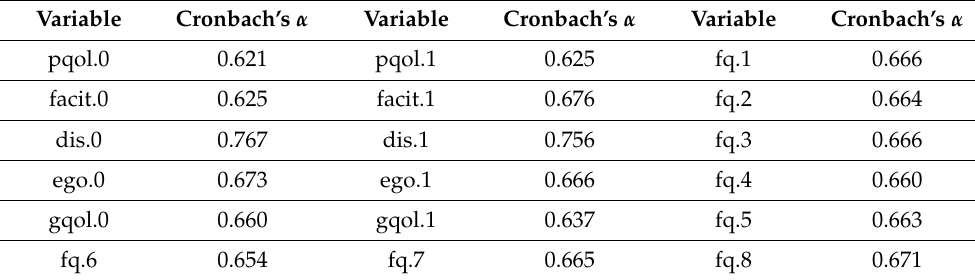
Table 3. Results of reliability analysis.